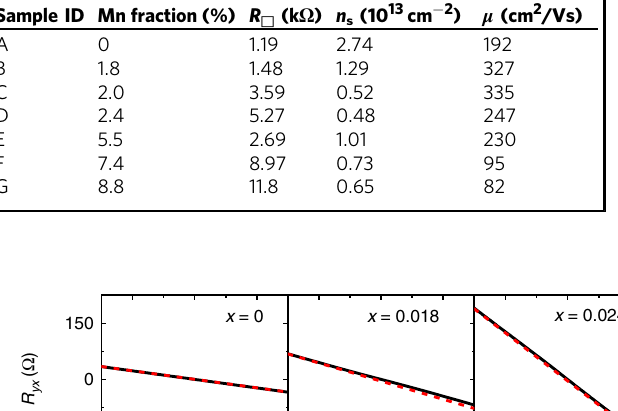
Table 1 Basic transport characteristics of (Bi 1 − x Mn x ) 2 Se 3 ( x = 0.018 – 0.088). Here R □ , n s , and μ denote the sheet resistivity (i.e., resistance per square), sheet electron density, and mobility, respectively. The data were extracted from low fi eld magnetotransport measurements at T = 1.6 K